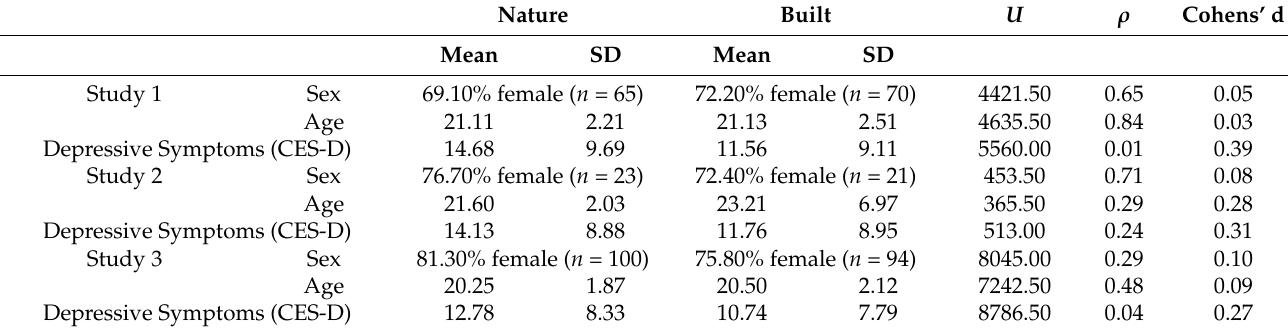
Table 2. Descriptive and Test Statistics for the Randomization